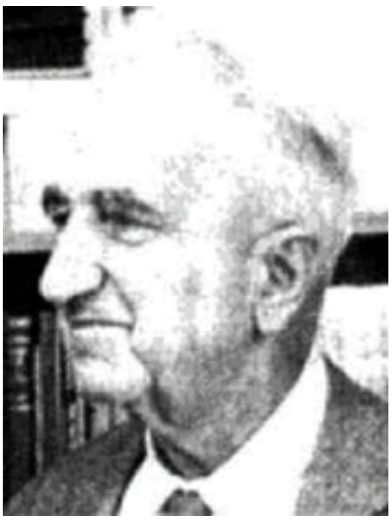
Figure 1: Johann Wilhelm Schwedler (1823-1894)